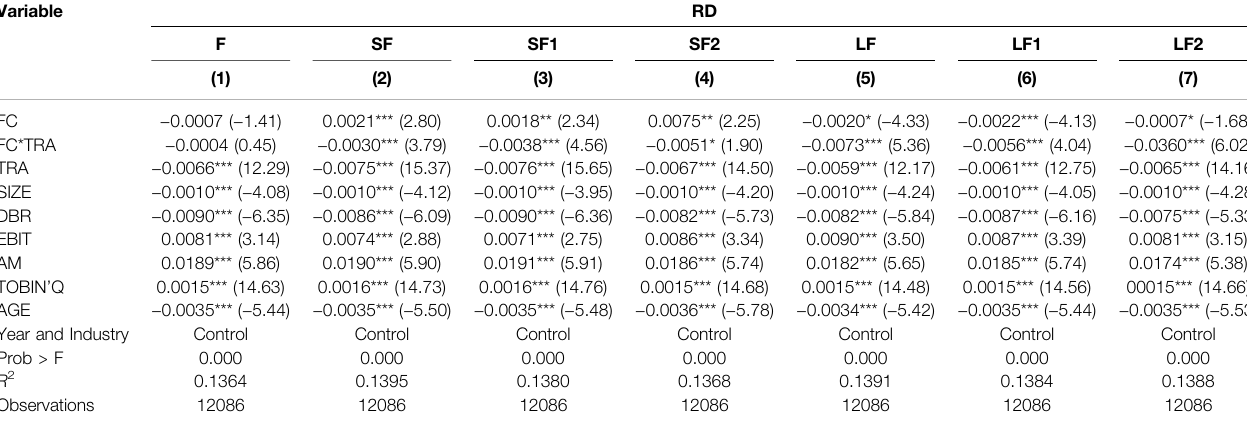
TABLE 5 | The regression results of the impact of asset turnover ratio on the relationship between fi nancialization and fi rm innovation. Variable RD